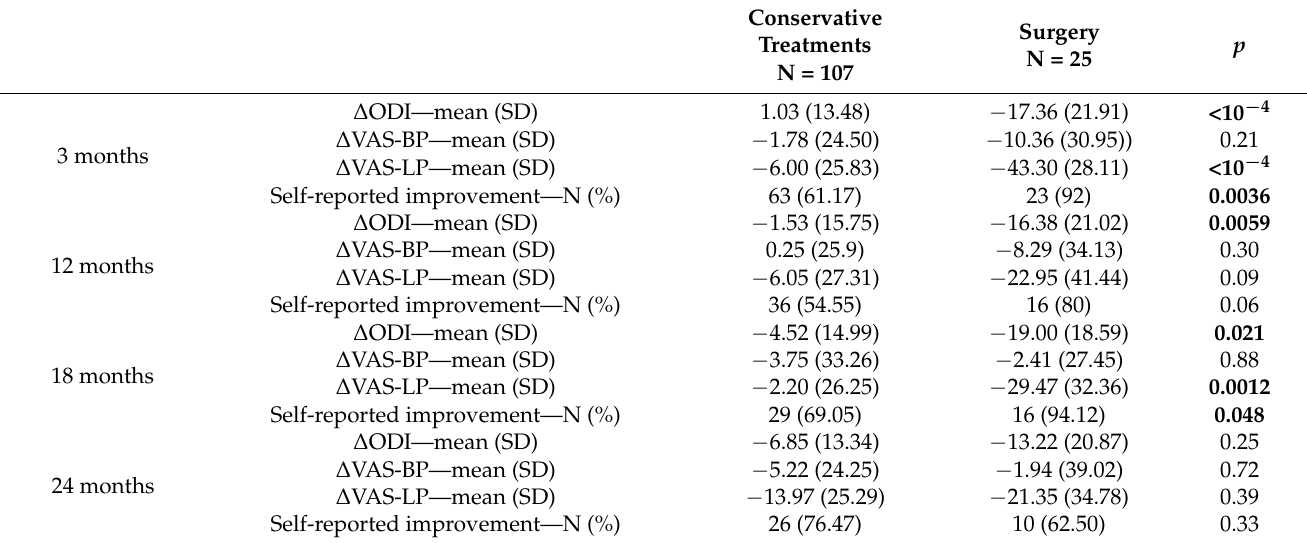
Table 2. Changes in Oswestry disease index, VAS back pain and VAS leg pain at 3,12,18 and 24 months (univariate